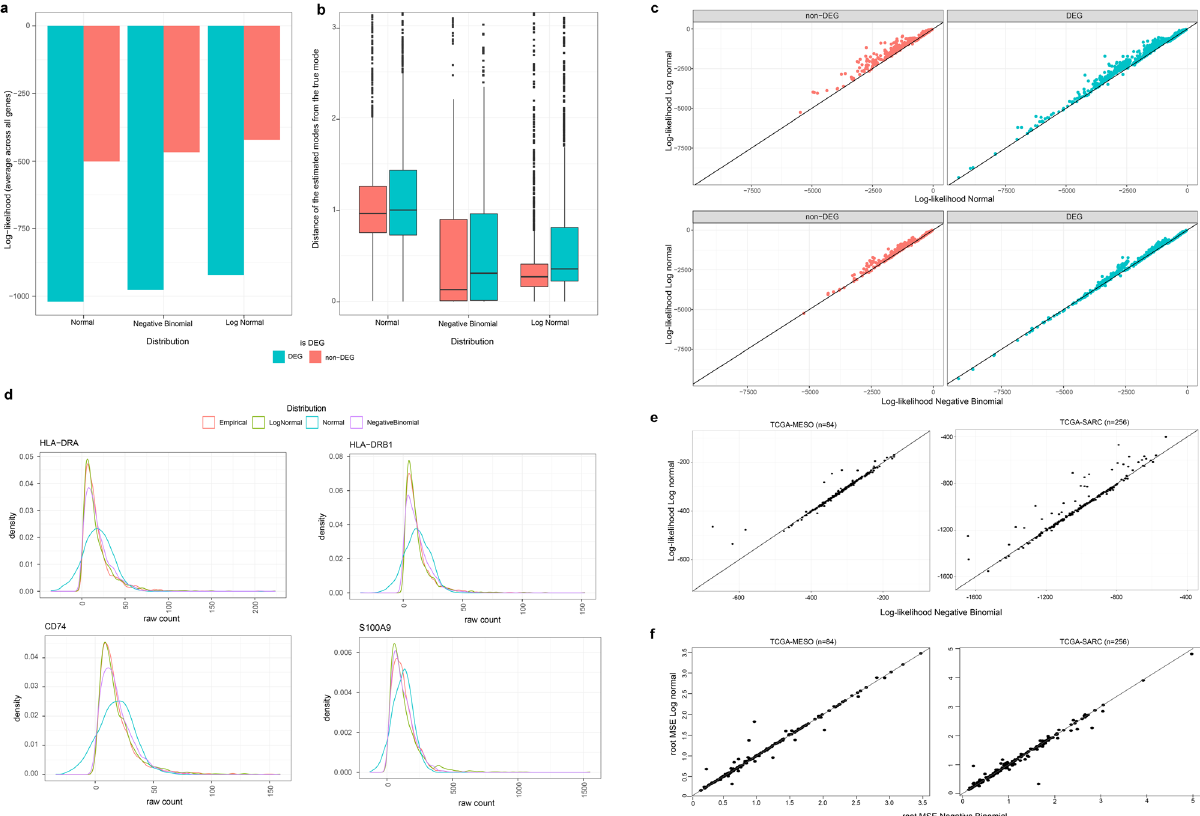
Fig. 2 Comparison of normal, negative binomial, and log-normal distribution in fi tting linear-scale gene expression data. a A bar chart of average log- likelihood of the three types of distribution fi tted to PBMC single-cell RNA-seq data. The genes were split by DEGs (red; n = 1723) and non-DEGs (blue; n = 1496). b Comparison of the distance of the estimated mode to the true mode ( y -axis) per distribution type (x-axis). The standard boxplot notation was used (lower/upper hinges — fi rst/third quartiles; whiskers extend from the hinges to the largest/lowest values no further than 1.5 * inter-quartile ranges). c Pairwise comparison of per-gene log-likelihood of log-normal distribution ( y -axis) and that of normal ( x -axis; top) and negative binomial distribution ( x -axis; bottom). The genes were split into non-DEGs (left) and DEGs (right). d Density plots for raw-counts (red) and optimized log-normal (green), normal (blue), and negative binomial distribution (purple) for four example genes (gene name at the top) with low maximum log-likelihood for normal distribution. e , f Maximum log-likelihood values ( e ) and root mean squared error (root MSE: f ) of each gene for log-normal ( y -axis) and negative binomial ( x -axis) convolutions of T = 8 cell types, applied to TCGA-MESO (left) and TCGA-SARC (right)